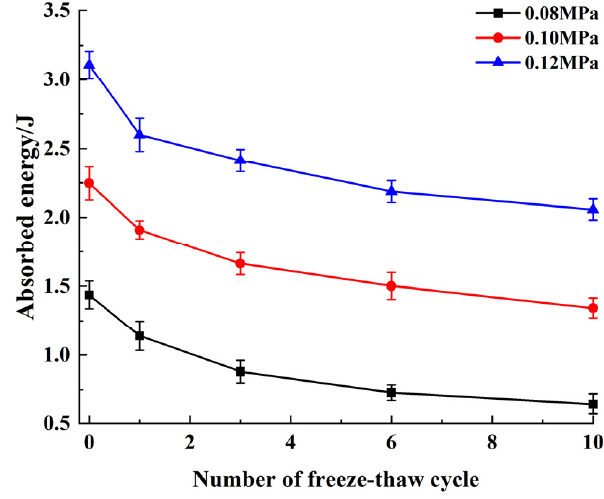
Figure 15. Freeze–thaw cycle effect on absorbed energy.